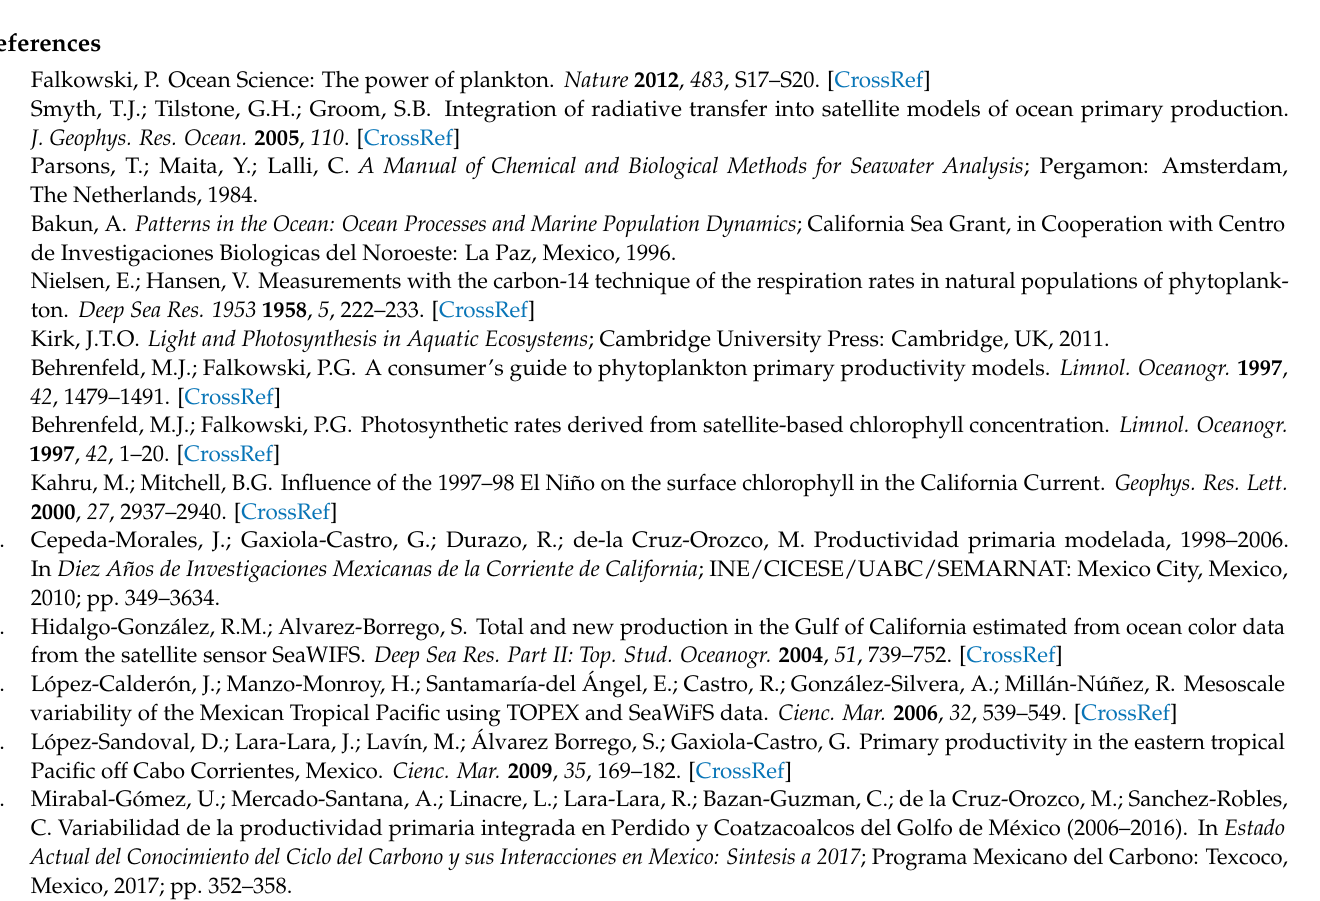
of NPP; Figure S3: Monthly climatology maps of SST; Figure S4: Monthly climatology maps of WSC; Figure S5: Monthly climatology maps of DEN; and Figure S6: Interannual monthly anomalies of NPP, SST, WSC and